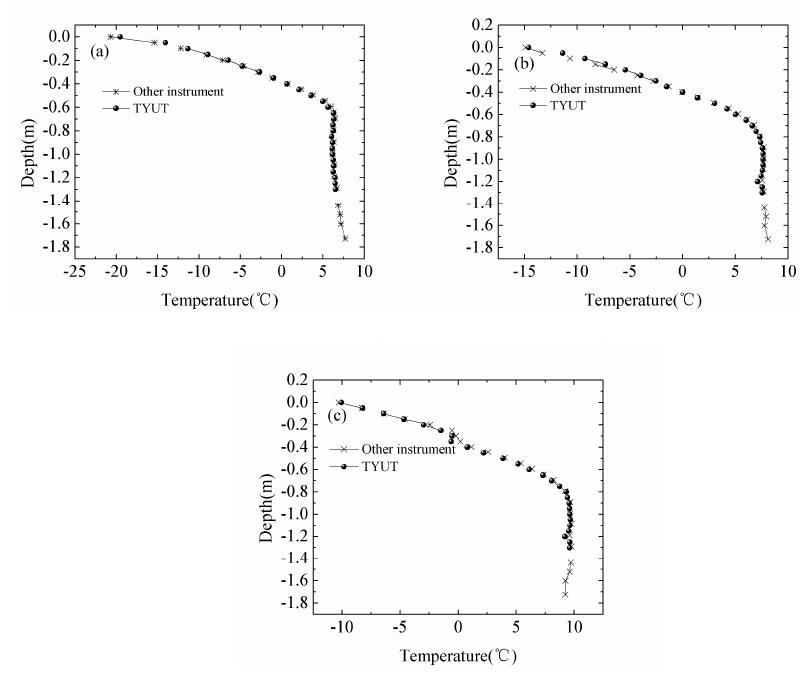
Figure 17. ( a ), ( b ), ( c ) are ice temperature curves of TYUT thermistor string and other instruments at 8:00 on 4 February, 13 February and 24 February, respectively.